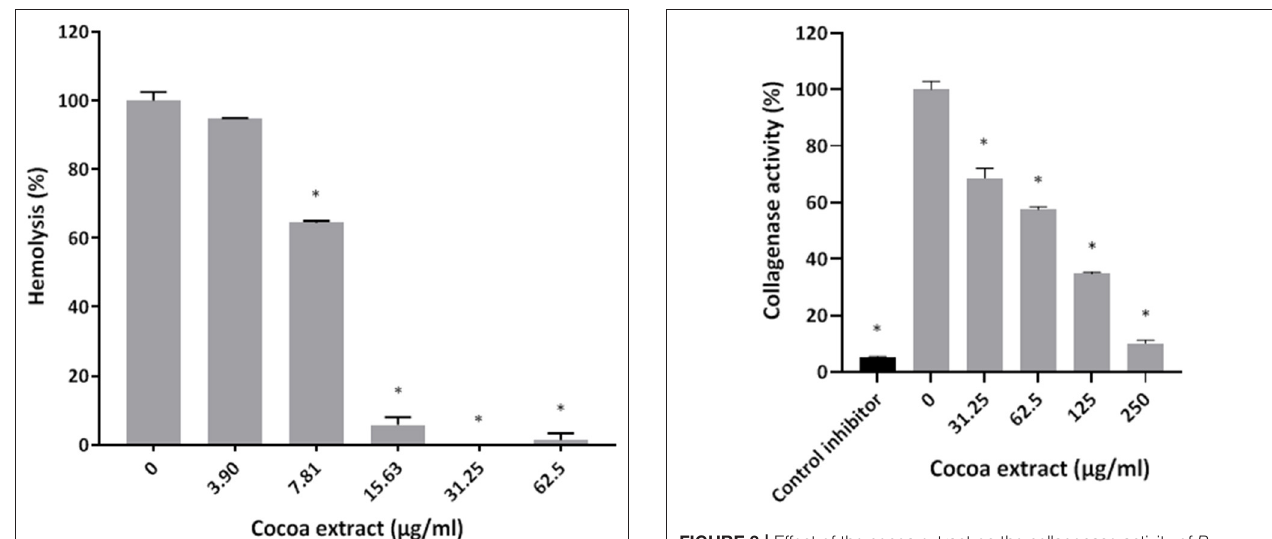
FIGURE 3 | Effect of the cocoa extract on the collagenase activity of P. gingivalis . Leupeptin was used as a control inhibitor. Collagen degradation was monitored by recording the fluorescence at excitation and emission wavelengths of 495 and 525nm, respectively, following a 60-min incubation at 37 ◦ C. A relative value of 100% was assigned to the degradation of type I collagen obtained in the absence of the cocoa extract. *significant inhibition ( p < 0.01) compared to the control (no cocoa